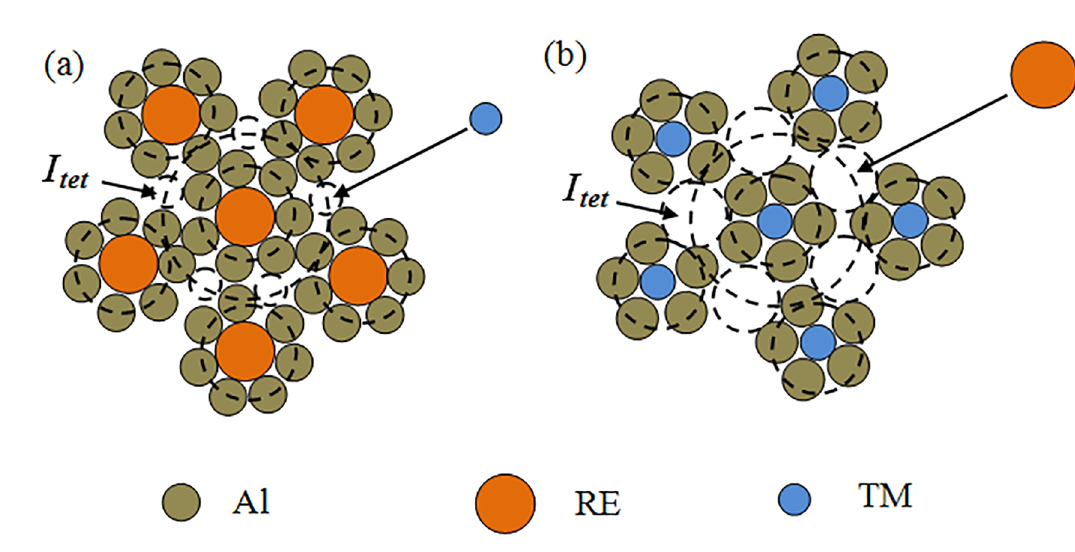
Figure 7. Icosahedral supercluster MRO structure model: (a) TM atoms occupy the tetrahedral sites; (b) RE atoms occupy the tetrahedral sites.